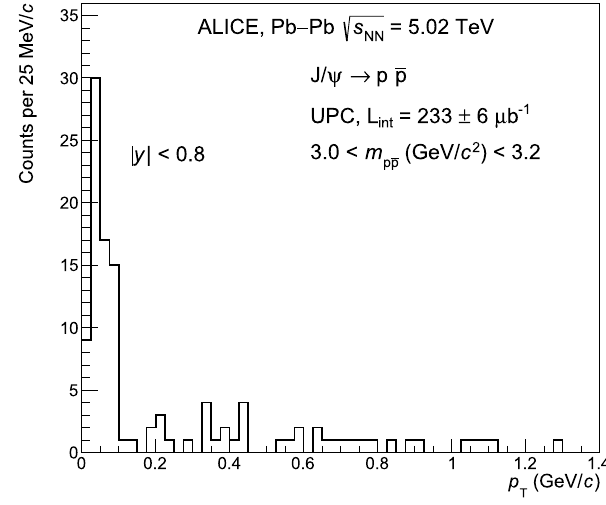
background and signal functions. Right: Transverse momentum distri- bution of J /ψ candidates in the range quoted in the figure (around the